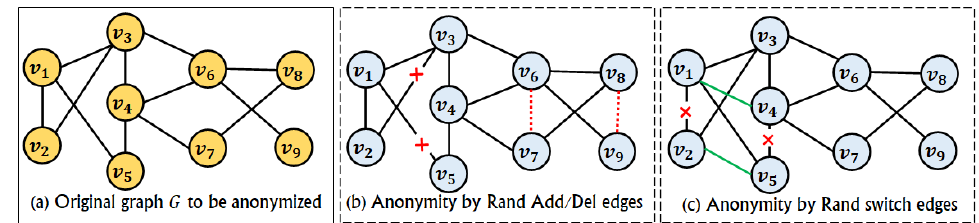
Figure 12. Example of G anonymization by the unconstrained (a.k.a. random) anonymization method.